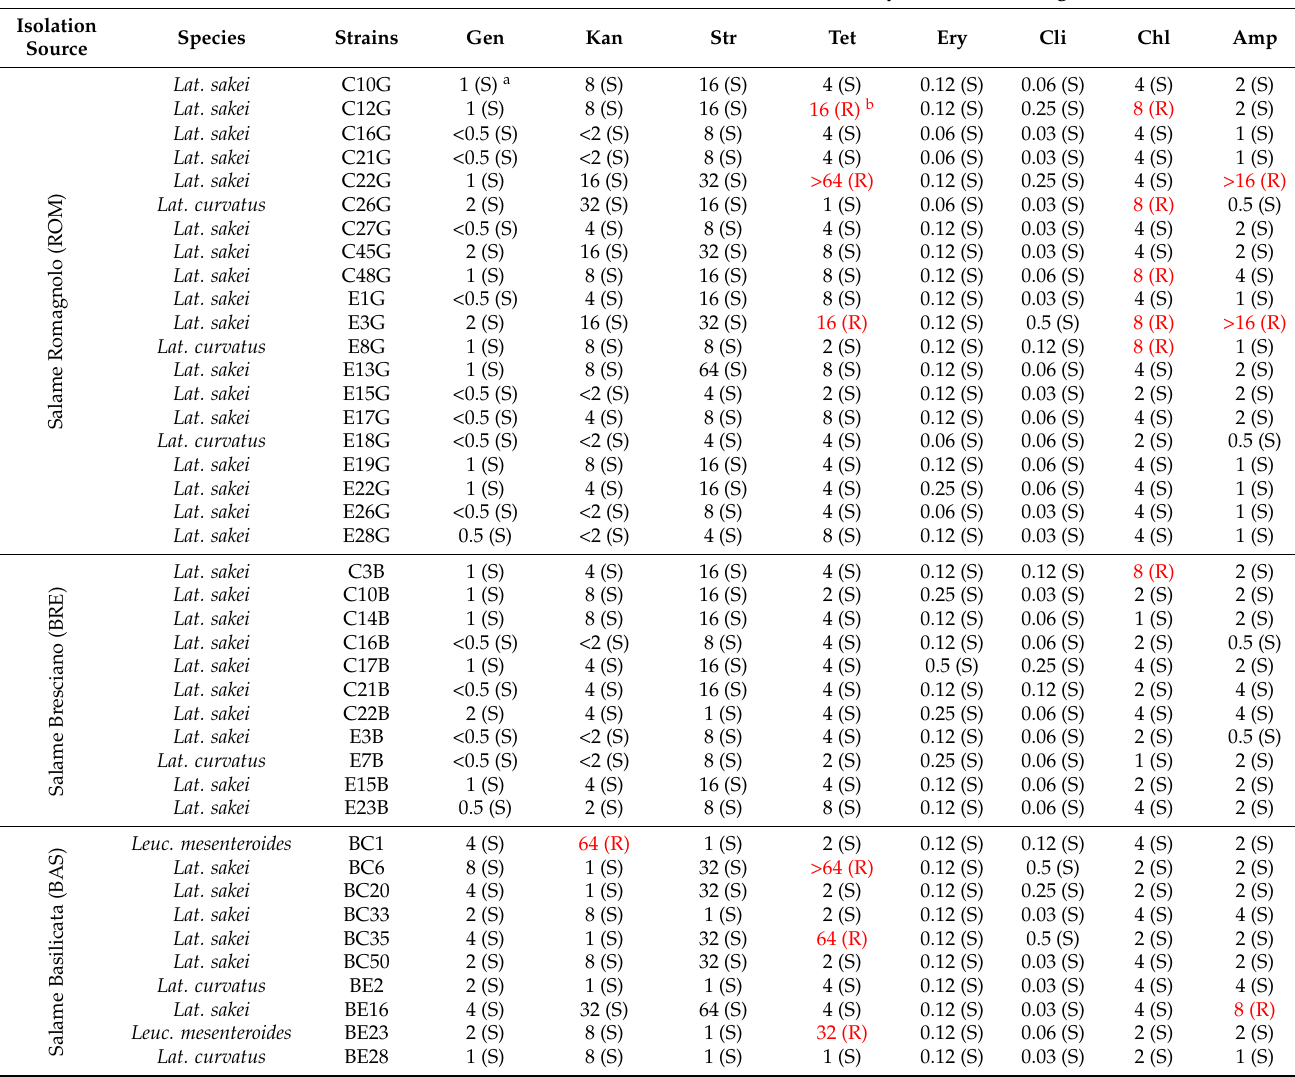
Table 5. Phenotypic characterization of the antibiotic resistance in LAB meat-borne strains previously